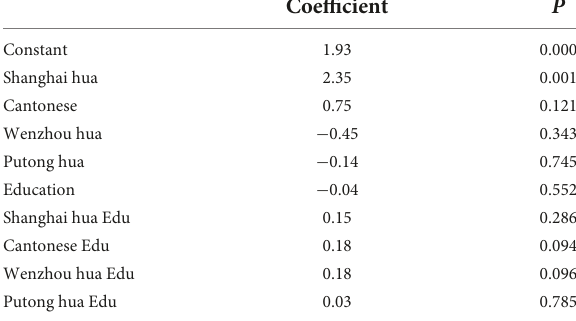
TABLE 10 Moderation effect of professional motivation.